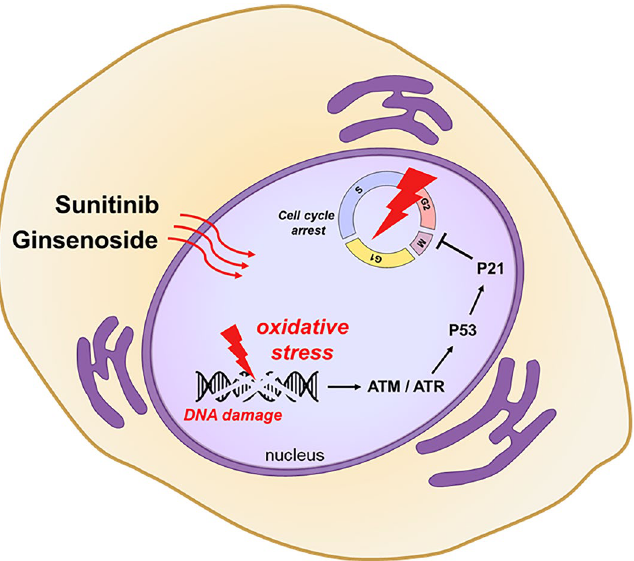
Figure 5. Ginsenoside increases DNA damage due to sunitinib to induce cell death by cell cycle arrest. Combination treatment of sunitinib and ginsenoside Rh2 induces oxidative stress in ccRCC. The DNA damage by oxidative stress arrests the cell cycle and inhibits cell growth of